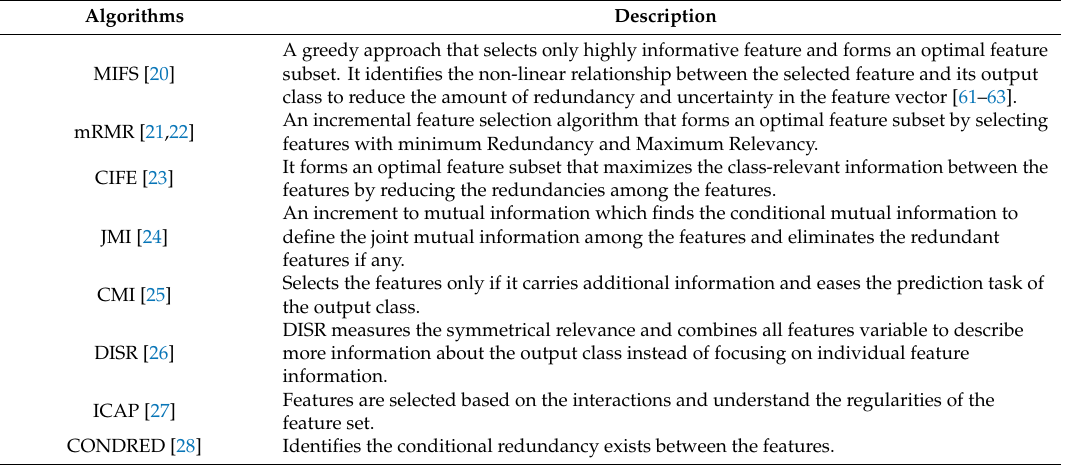
Table 2. Mutual information-based feature selection